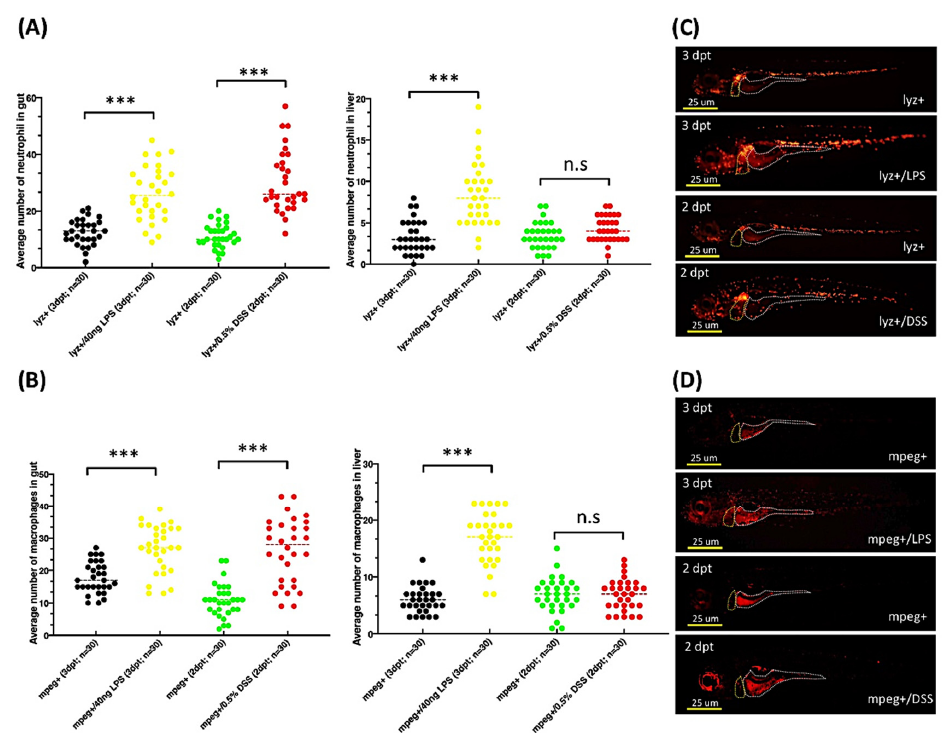
Figure 6. Increases in the numbers of neutrophils and macrophage in the gut and liver of lyz +/LPS, lyz +/DSS, mpeg1 +/LPS, and mpeg1 +/DSS zebrafish larvae exposed to LPS or DSS. Quantification (via fluorescence) of the number of cells in the gut and liver of zebrafish larvae testing positive for ( A ) neutrophils (lyz +) or ( B ) macrophages ( mpeg1 +) accompanied by representative fluorescence images of ( C ) neutrophils and ( D ) macrophages. Differences among the variables were assessed using Student’s t -tests. Statistical significance: *** p < 0.001. Scale bar: 25 μ m.